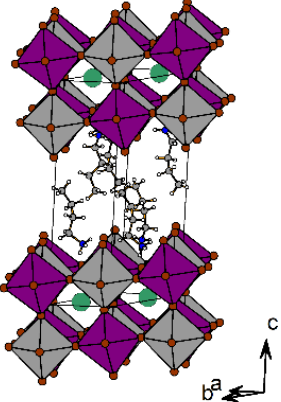
Figure 1. A unit cell of a single crystal of ( BA ) on our single crystal structure investigation and plotted using DIAMOND software.